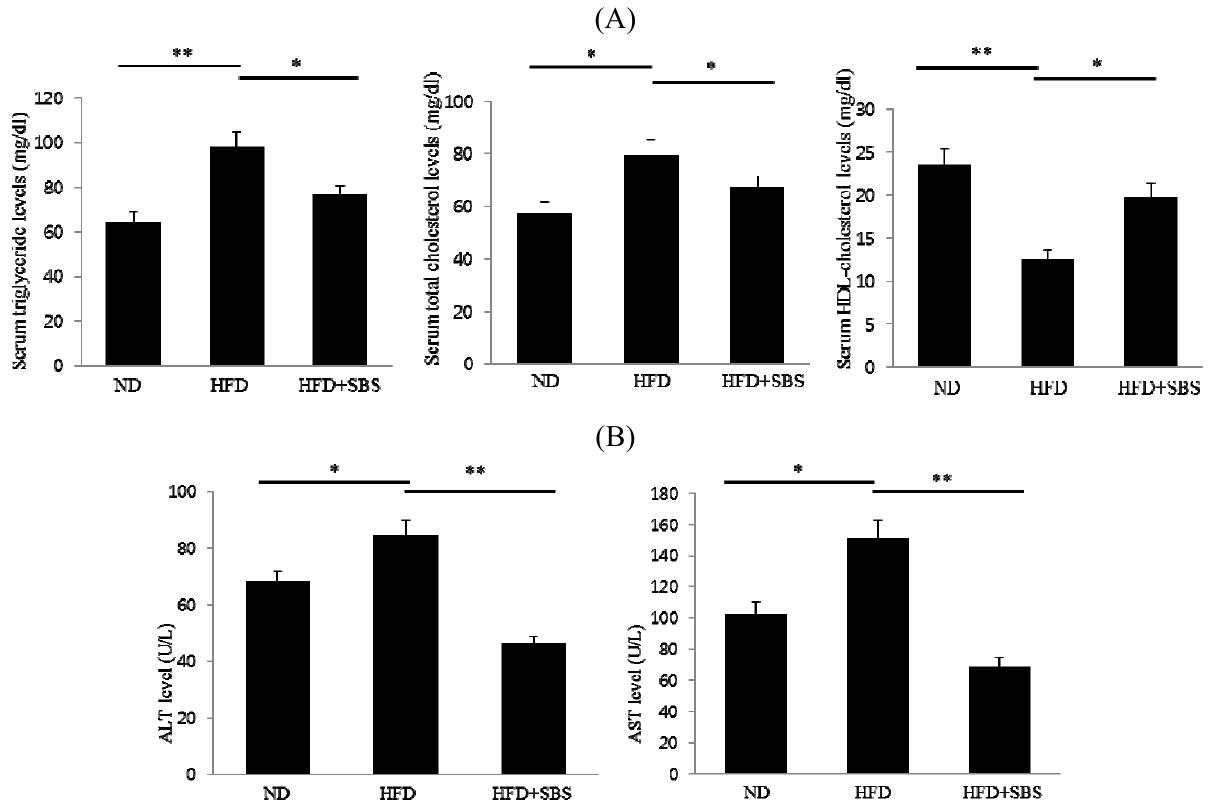
Figure. 1. Effect of SBS on serum lipid contents in HFD-fed rats. ( A ) Serum TG and TC levels in rats fed a normal diet (ND), high-fat diet (HFD), and high-fat diet supplemented with SBS. Serum TG and TC levels were significantly reduced in rats treated with HFD + SBS compared to HFD. The values are expressed as the mean ± SD. * p < 0.05, ** p < 0.01. ( B ) Serum levels of AST and ALT of rats fed ND, HFD, and HFD + SBS. The values are expressed as the mean ± SD. * p < 0.05, ** p <